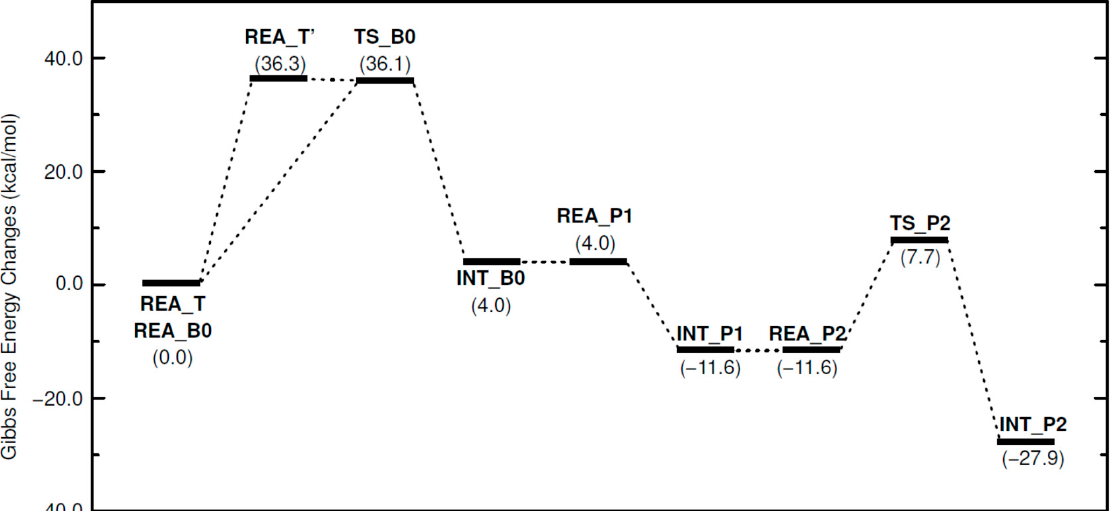
Figure 5. Free energy changes in phenol–epoxide ring-opening reaction using TPP-K. Relative free energies (kcal/mol) to REA_T and REA_B0 are in parentheses.